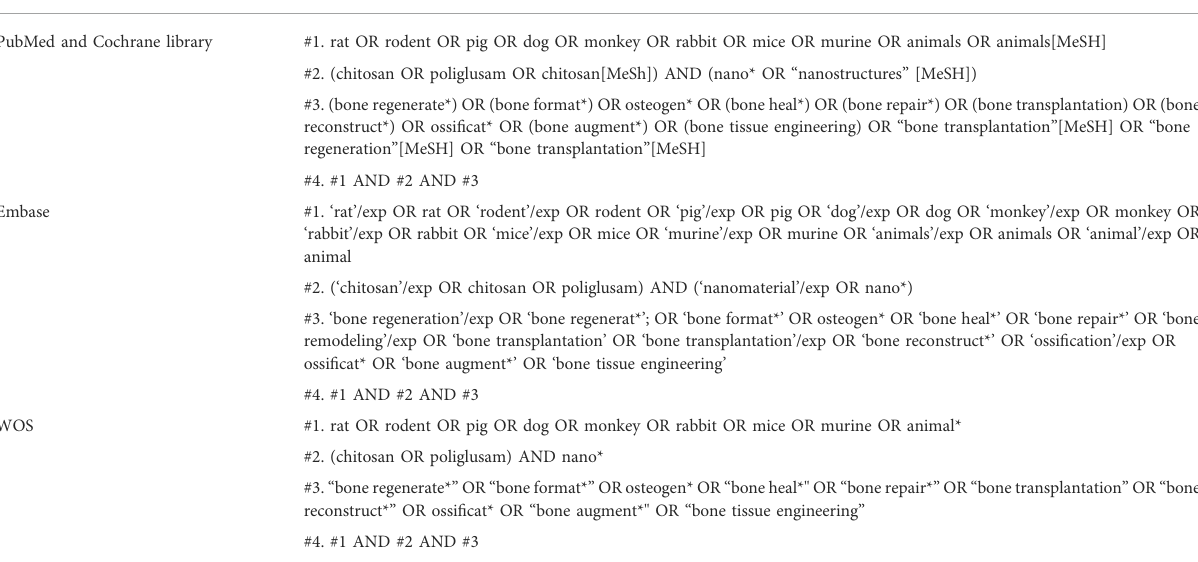
TABLE 1 Search strategies in different